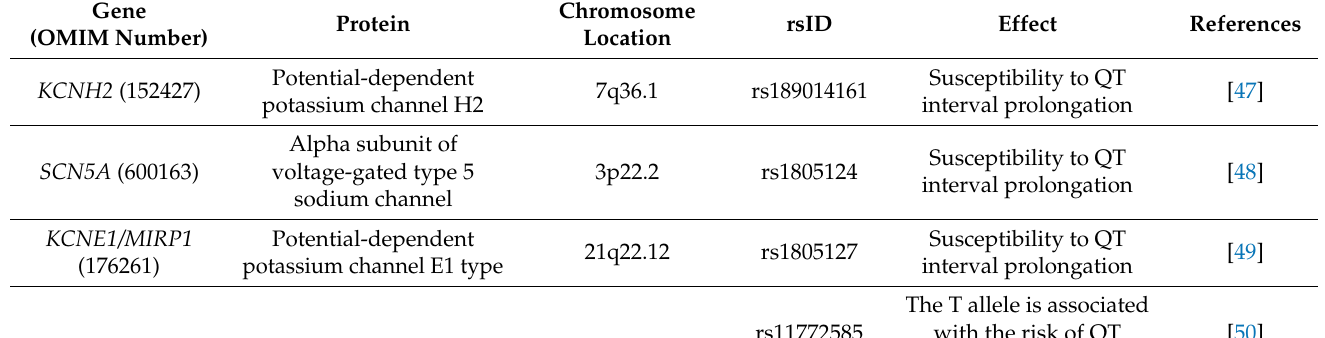
Table 3. Candidate genes and their single nucleotide variants predisposing to QT prolongation.